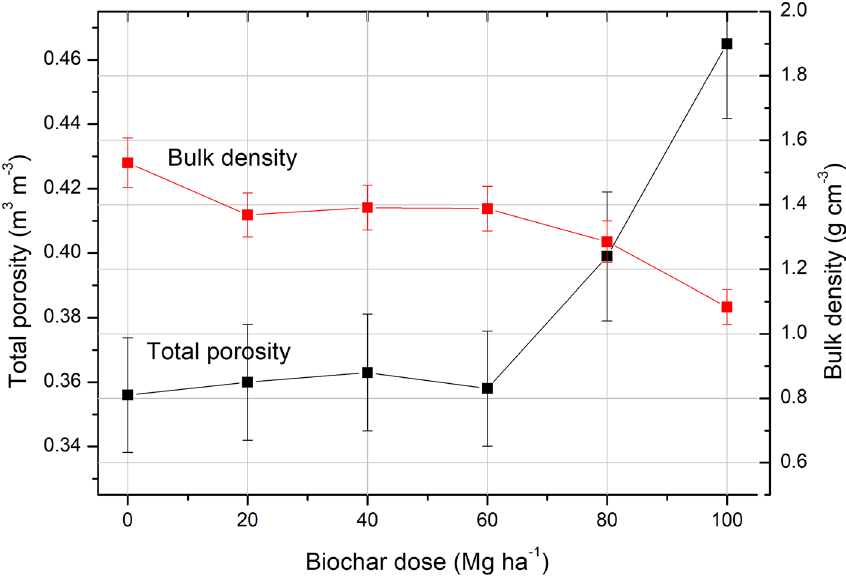
Figure 4. Bulk density (red graph) and total porosity (black graph) with the uncertainties (red and black vertical lines) as a function of the biochar dose applied into the soil. Data for six samples investigated in the laboratory for assessment of the emanation coefficient.